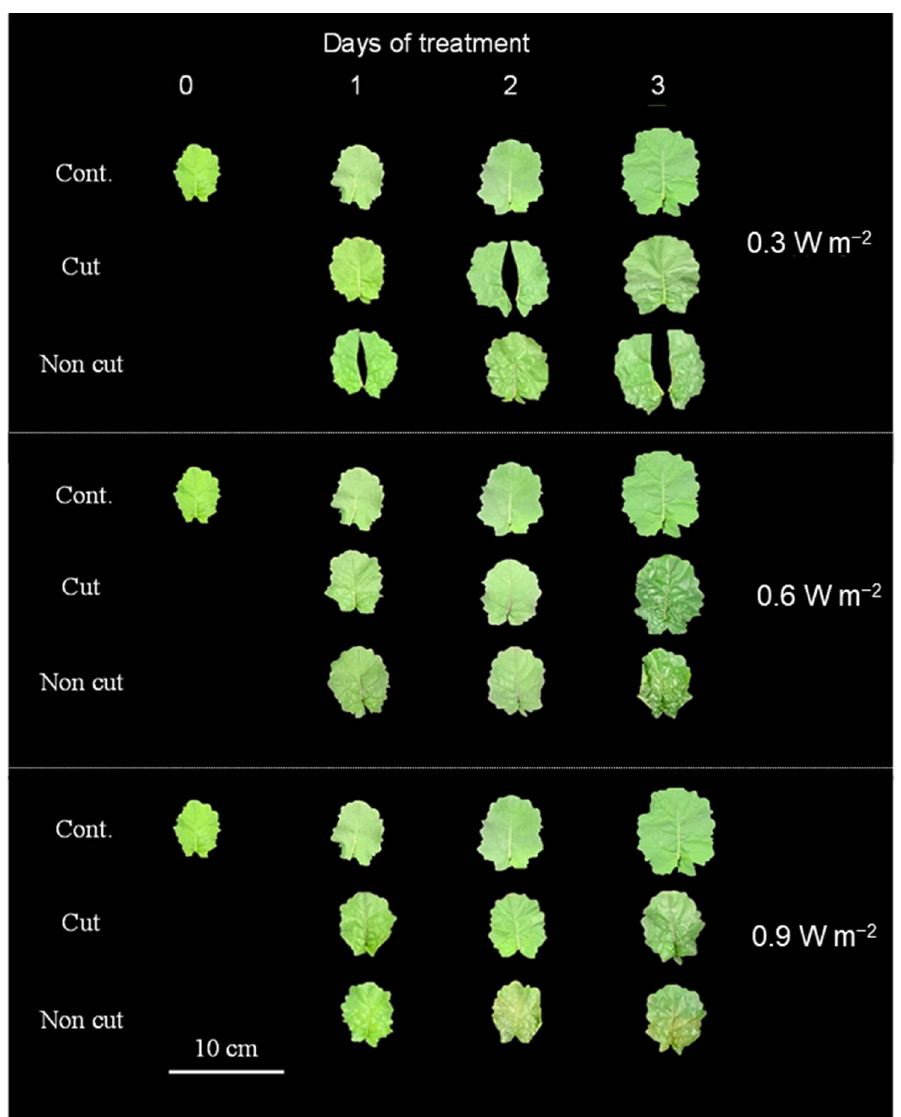
Figure 3. Second and third leaves of canola plants grown under UV irradiation with or without 300 nm short-cut filters. UV irradiation intensity was set at 0.3, 0.6, and 0.9 W m −2 .